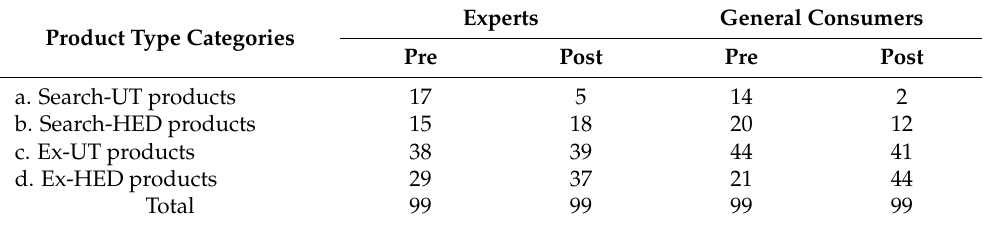
Table 12. Ninety-nine cases classified according to 4 product type categories.